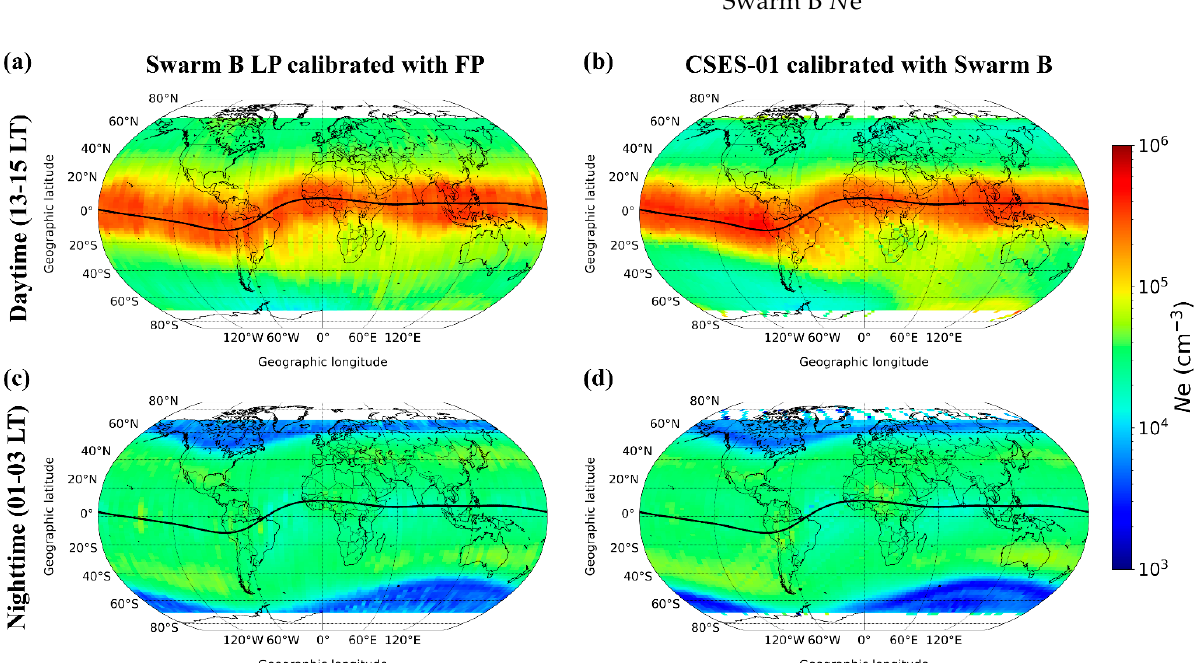
Figure 7. Geographical maps of mean N e values measured by Swarm B LP after the calibration with FP observations (Panels ( a , c )) and geographical maps of mean N e values measured by CSES-01 LP after applying the calibration procedure based on Swarm B data (Panels ( b , d )). Panels ( a , b ) are for the daytime sector (13:00 − 15:00 LT); Panels ( c , d ) are for the nighttime sector (01:00 − 03:00 LT). The thick black curve in each plot represents the geomagnetic